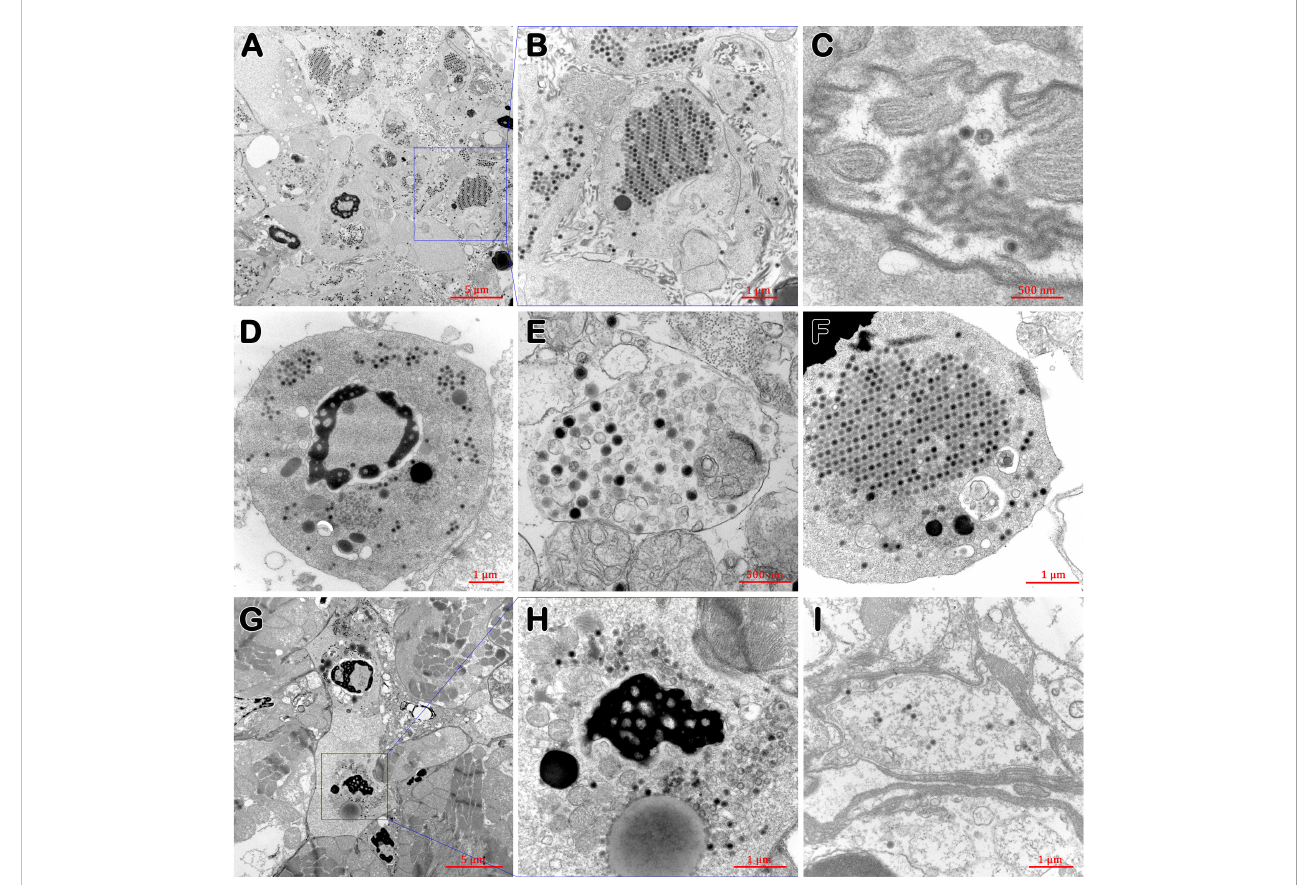
FIGURE 5 TEM of tissues of diseased P. japonicus (from PO and IM groups). (A, B) lymphoid organ; (C) nervous tissue; (D – F) gills; (G, H) heart; (I) stomach. (A, B) , and (F) show the paracrystalline arrays of mature virions; H show the assembling virions. Bar: 5 µm (A, G) ; 1 µm (B, D, F, H, I) ; 500 nm (C, E) .